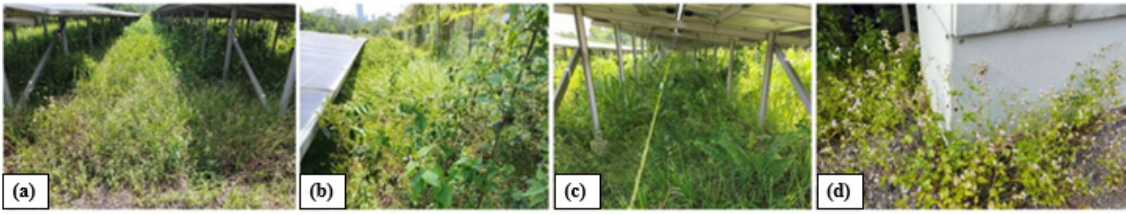
Figure 7. Spot ground conditions at the solar farm in Puchong.